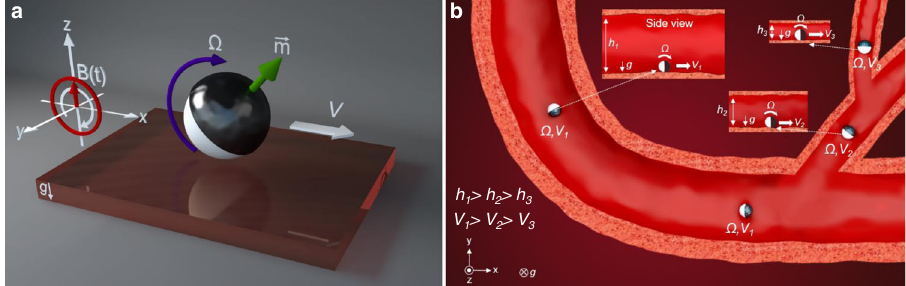
fl ow- fi eld symmetry by the presence of a near wall. b Schematic depicting the microrollers moving in cylindrical microchannels. The microroller translational speed declines as the con fi nement increases (smaller h ) due to the out-of-plane rotational fl ows